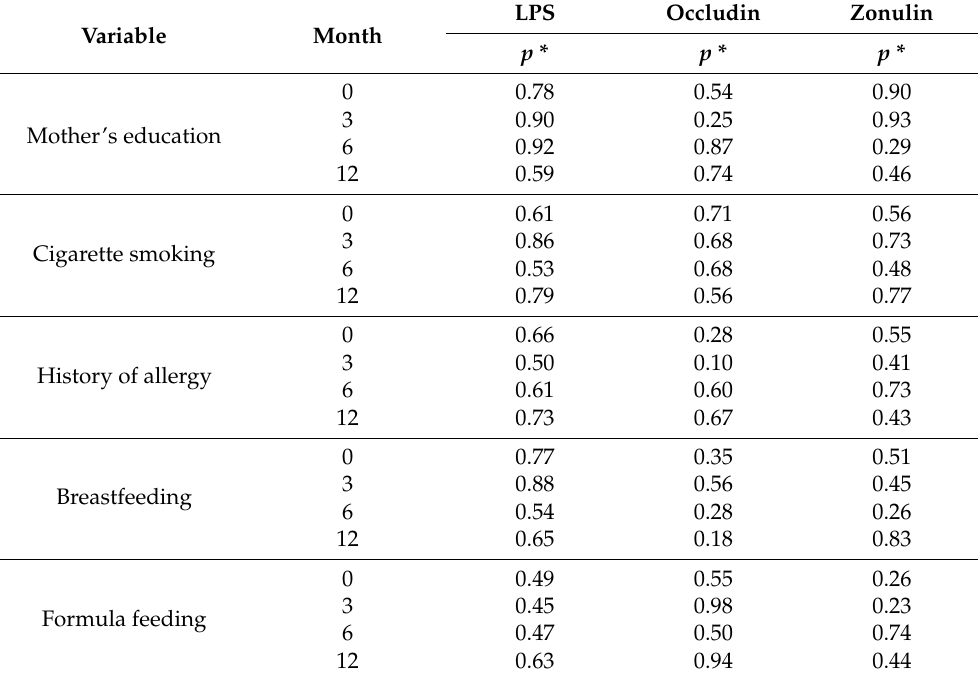
Table 3. Analysis of dependent